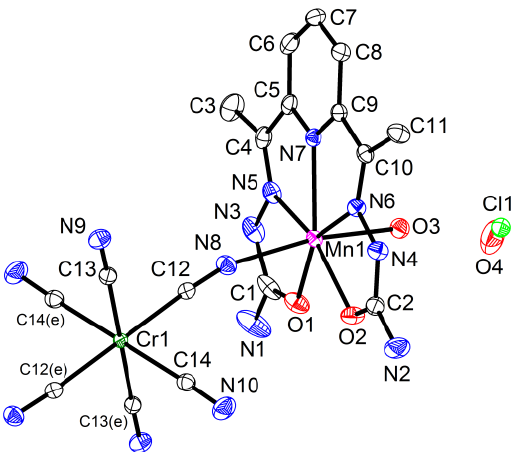
Figure 4. Asymmetric unit in 3 with atom numbering scheme (ORTEP drawing with 50% probability ellipsoids). Colored atoms: Cl (light green), Cr (green), Mn (magenta), N (blue), O (red). Symmetry code: (e) (1 − x , − y , − z ).